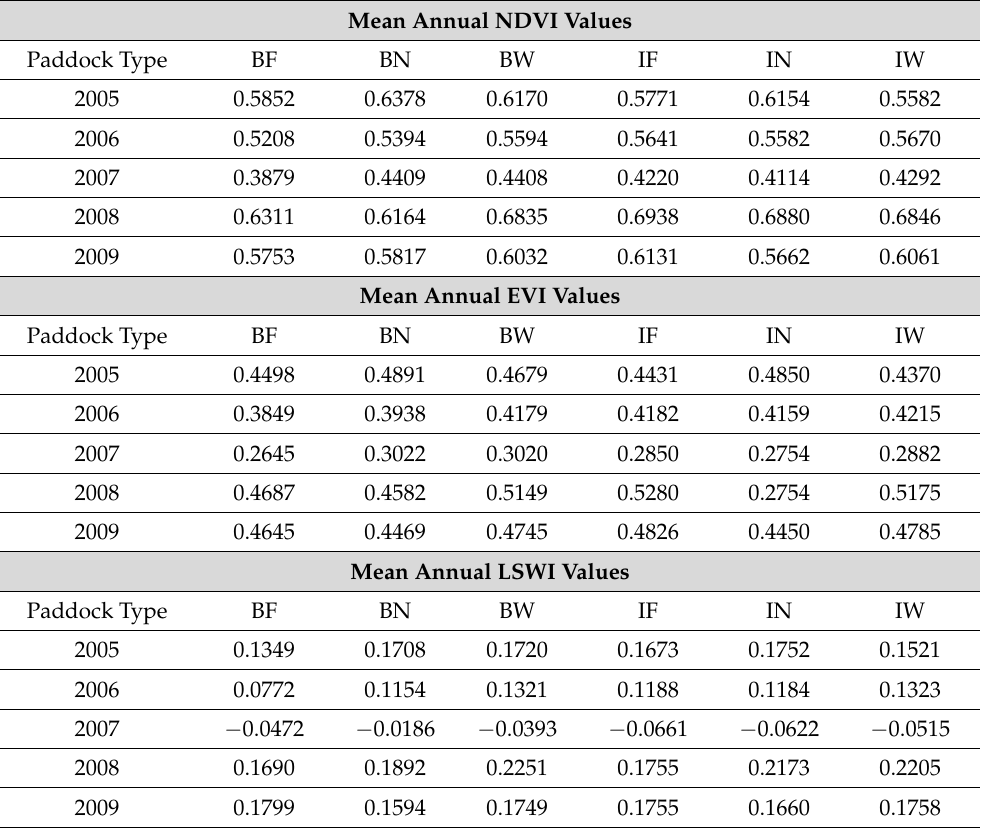
Table 3. Mean annual vegetation index values for normalized difference vegetation index (NDVI), enhanced vegetation index (EVI), and land surface water index (LSWI) between paddock types across all years (2005 to 2009) in the study. B: Broiler litter; I: Inorganic fertilizer; F: Endophyte-free; N: Novel endophyte; W: Wild